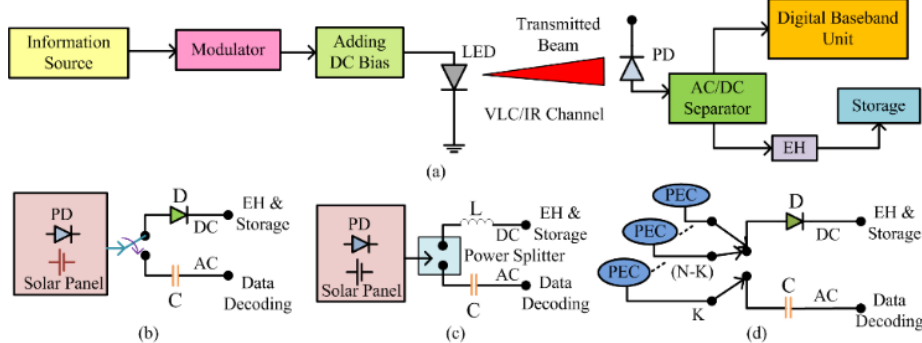
Figure 40. ( a ) VLC-based energy harvesting model; ( b ) receiver based on time switching; ( c ) receiver based on signal component separation; and ( d ) receiver based on PEC architectures.